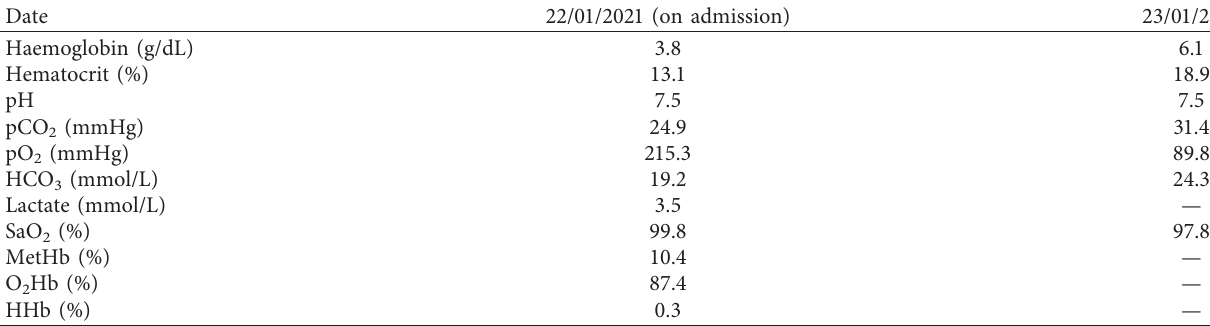
Table 1: Lab investigations.